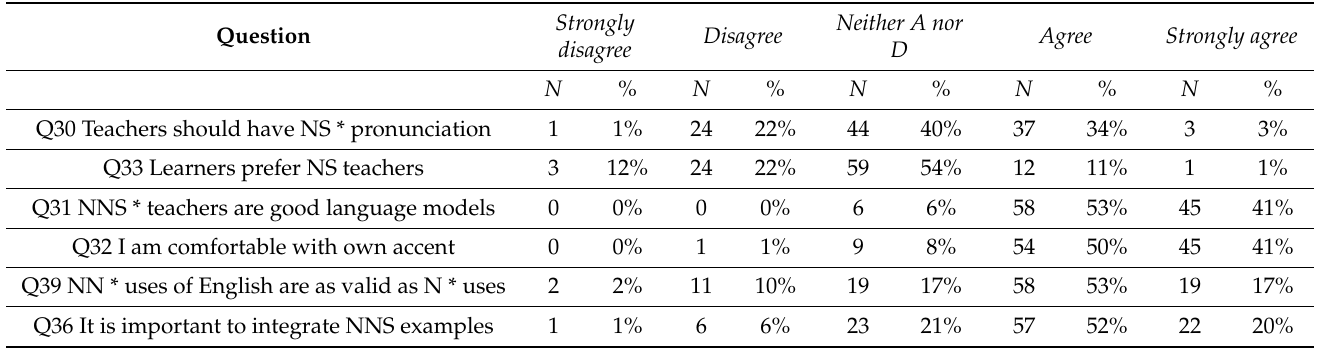
Table 2. Teacher beliefs about English use in teaching